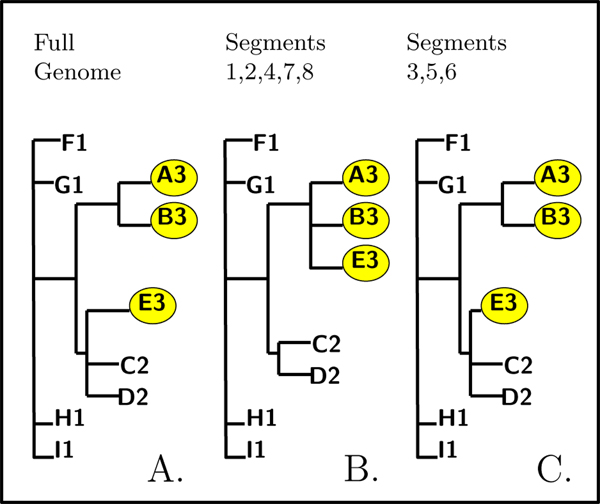
Reassortment search